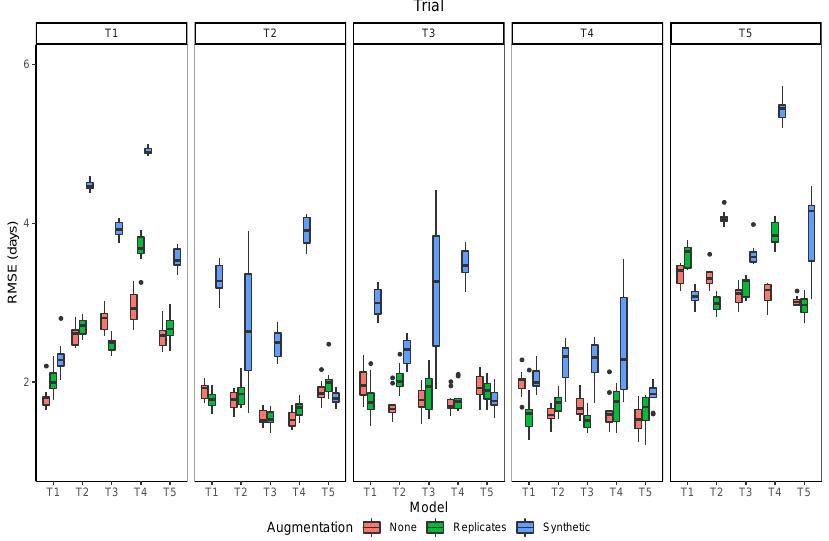
Figure 11. Prediction performance measured by the root mean squared error (RMSE) as related to different data augmentation